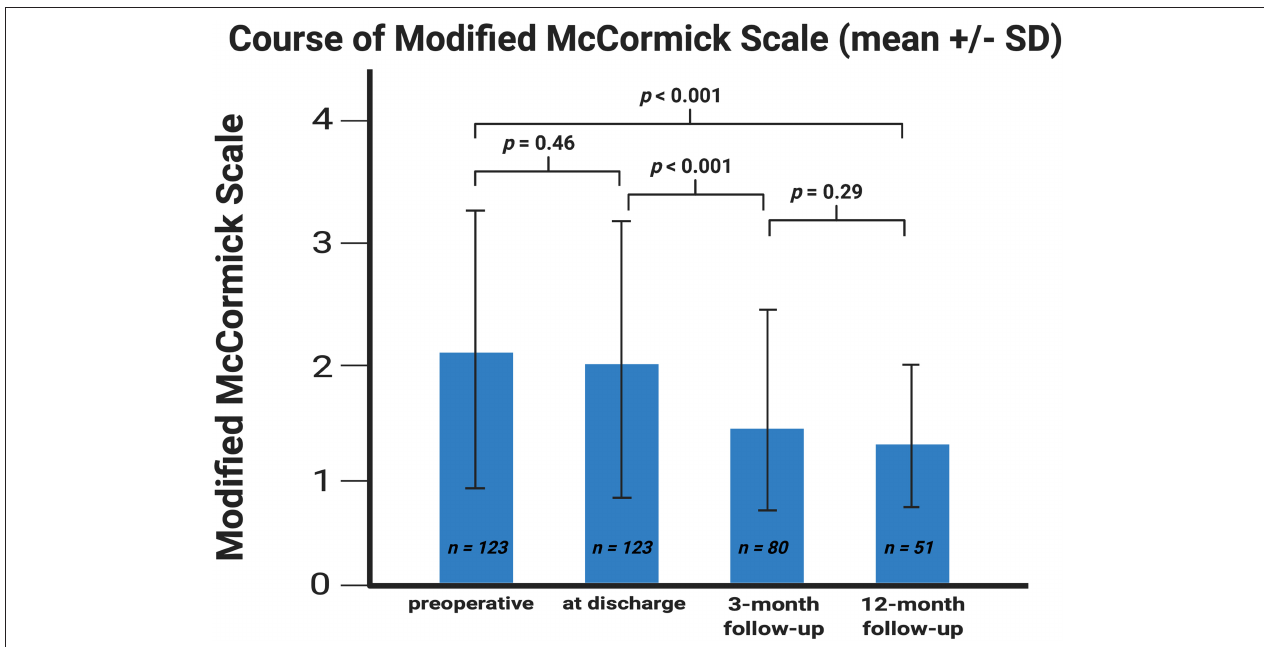
FIGURE 1 | Error bar showing the means and standard deviation of the Modified McCormick scale. X-axis represents the baseline at discharge and at the 3- and 12-month follow-up examinations. Y-axis represents the Modified McCormick scale. P -values of the paired t -test comparing the mean values are shown. The means ( ± SD) were 2.11 ± 1.13, 1.98 ± 1.13, 1.54 ± 0.84, and 1.40 ± 0.63 (sorted in chronological ascending order).